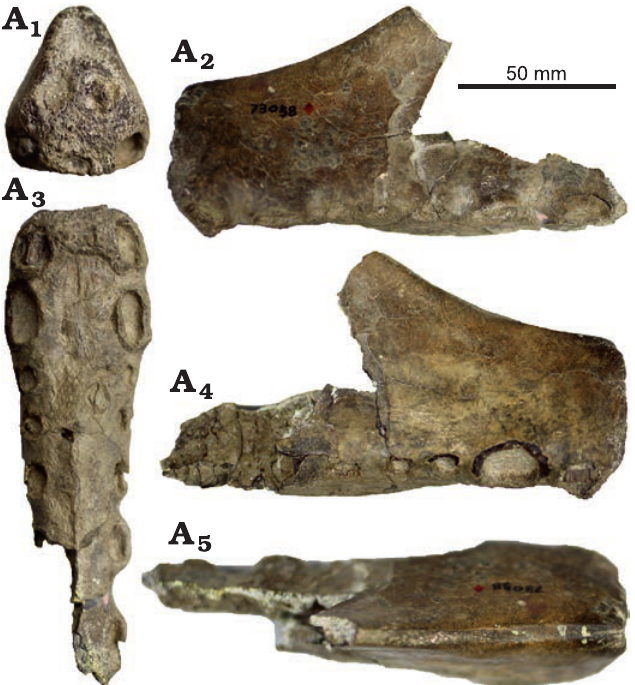
Fig. 4. Anhanguerid pterosaur Uktenadactylus wadleighi (Lee, 1994), SMU 73058, Tarrant County, Texas, USA, Albian. In anterior (A 1 ), left lateral (A 2 ), palatal (A 3 ) and right lateral (A 4 ), and dorsal (A 5 ) views. Photographs by BH.